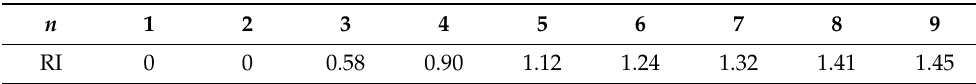
Table 2. The value of the random consistency indicator